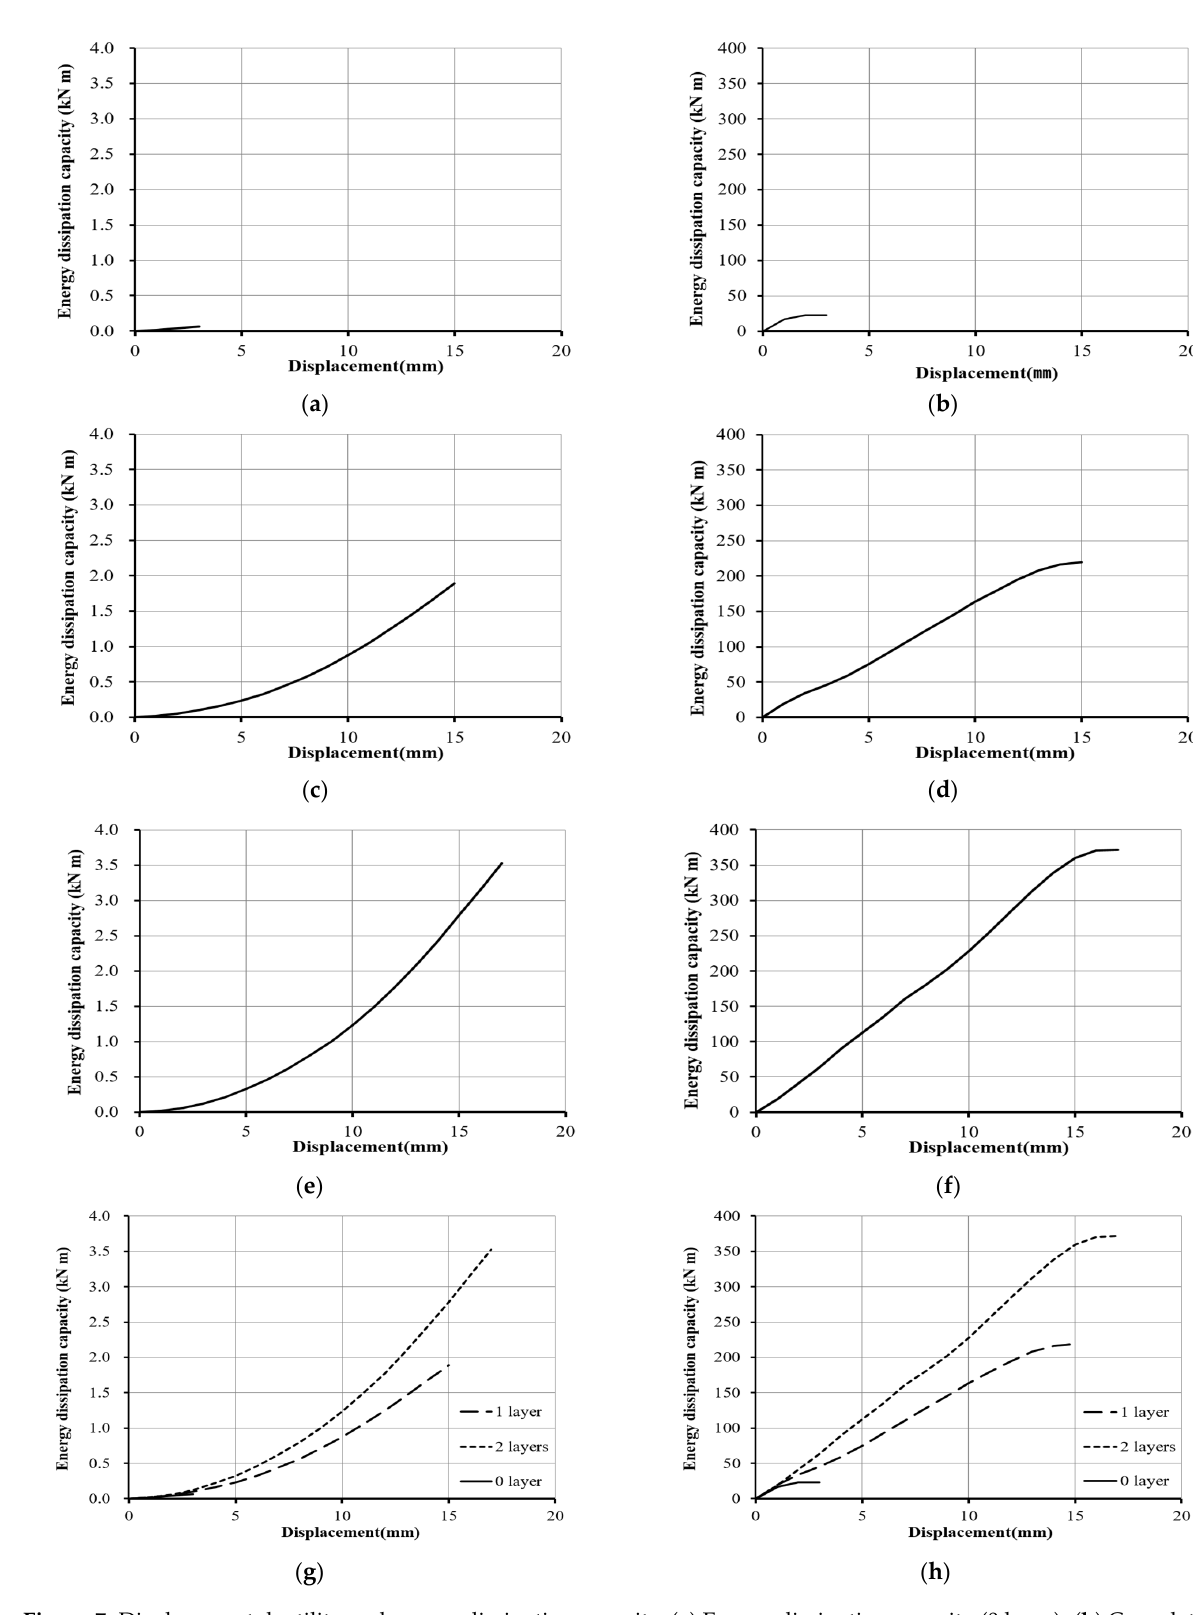
( f ) Figure 6. Results for specimens. ( a ) Fracture pattern (0 layer). ( b ) Load–displacement curve (0 layer). ( c ) Fracture pattern (1 layer). ( d ) Load–displacement curve (1 layer). ( e ) Fracture pattern (2 layer). ( f ) Load–displacement curve (2 layer). The energy dissipation capacity of the concrete panels was 0.06 kN ∙ m with no layers, 1.89 kN ∙ m with one layer, and 3.52 kN ∙ m with two layers, and increased with the increas- ing number of carbon fiber grids (Figure 7). The energy dissipation capacity increased by 30 times with one layer and by 56 times with two layers compared with no layers, showing